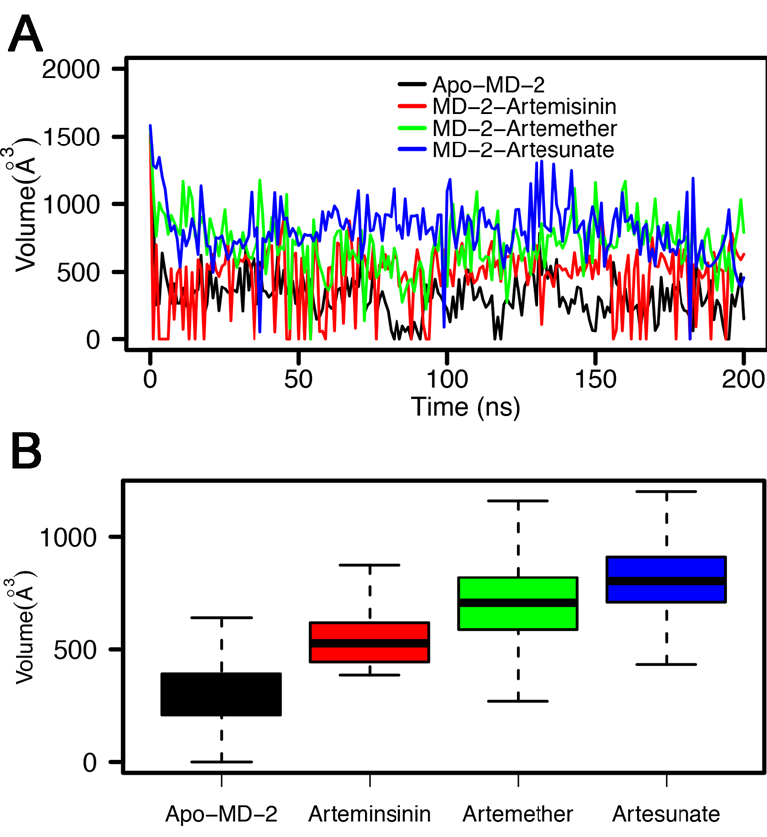
Figure 8. Ligand binding pocket volume ( A ) in line plot as a function of simulation time and ( B ) in barplot for Apo-MD-2, MD-2-Artemisinin, MD-2-Artemether and MD-2-Artesunate systems over the 200ns